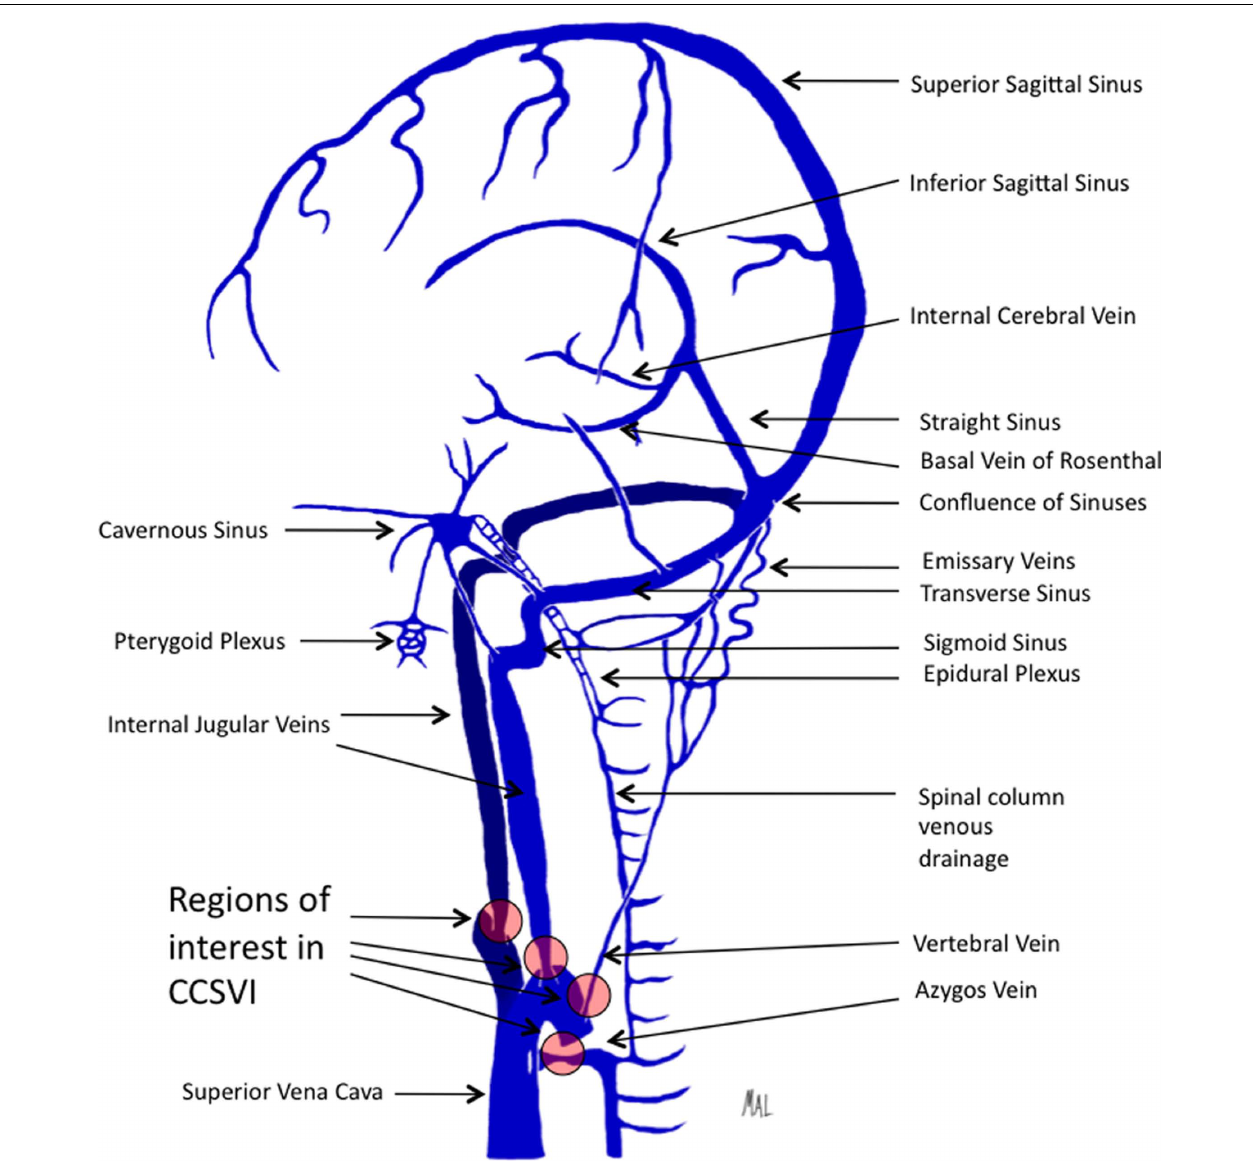
FIGURE 1 | Illustration depicting the predominant veins and sinuses involved in the craniocervical venous outflow. Venous narrowing is depicted at locations of interest in chronic cerebrospinal venous